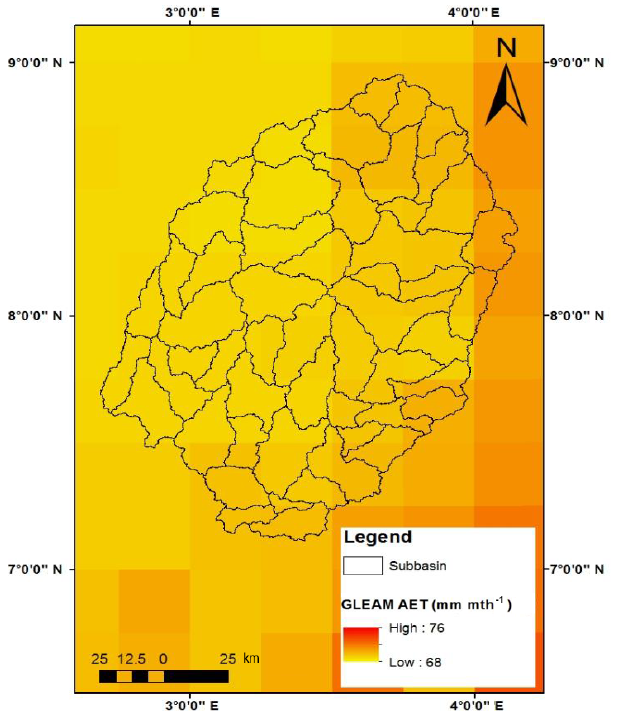
Figure D1. Mean monthly actual evapotranspiration of GLEAM_v3.0a over the entire Ogun River Basin for 1989– 2012.